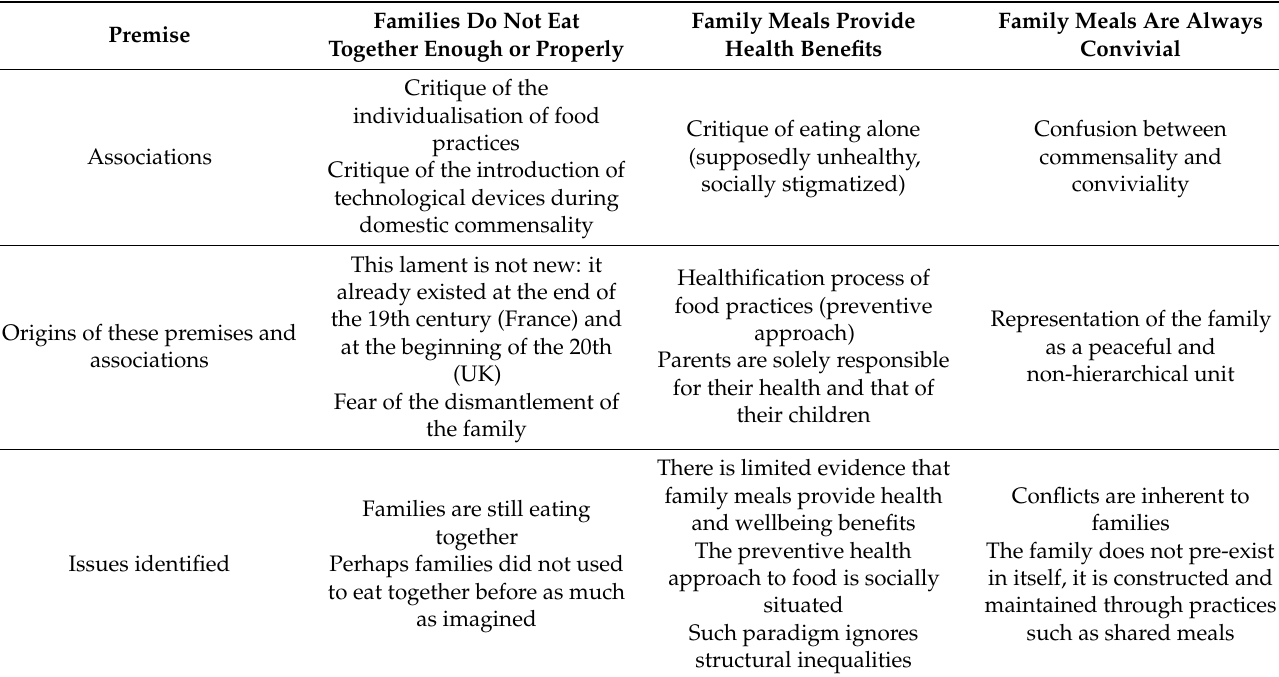
Table 2. The normative family meal promotion: assumption, premises and limitations. Premise